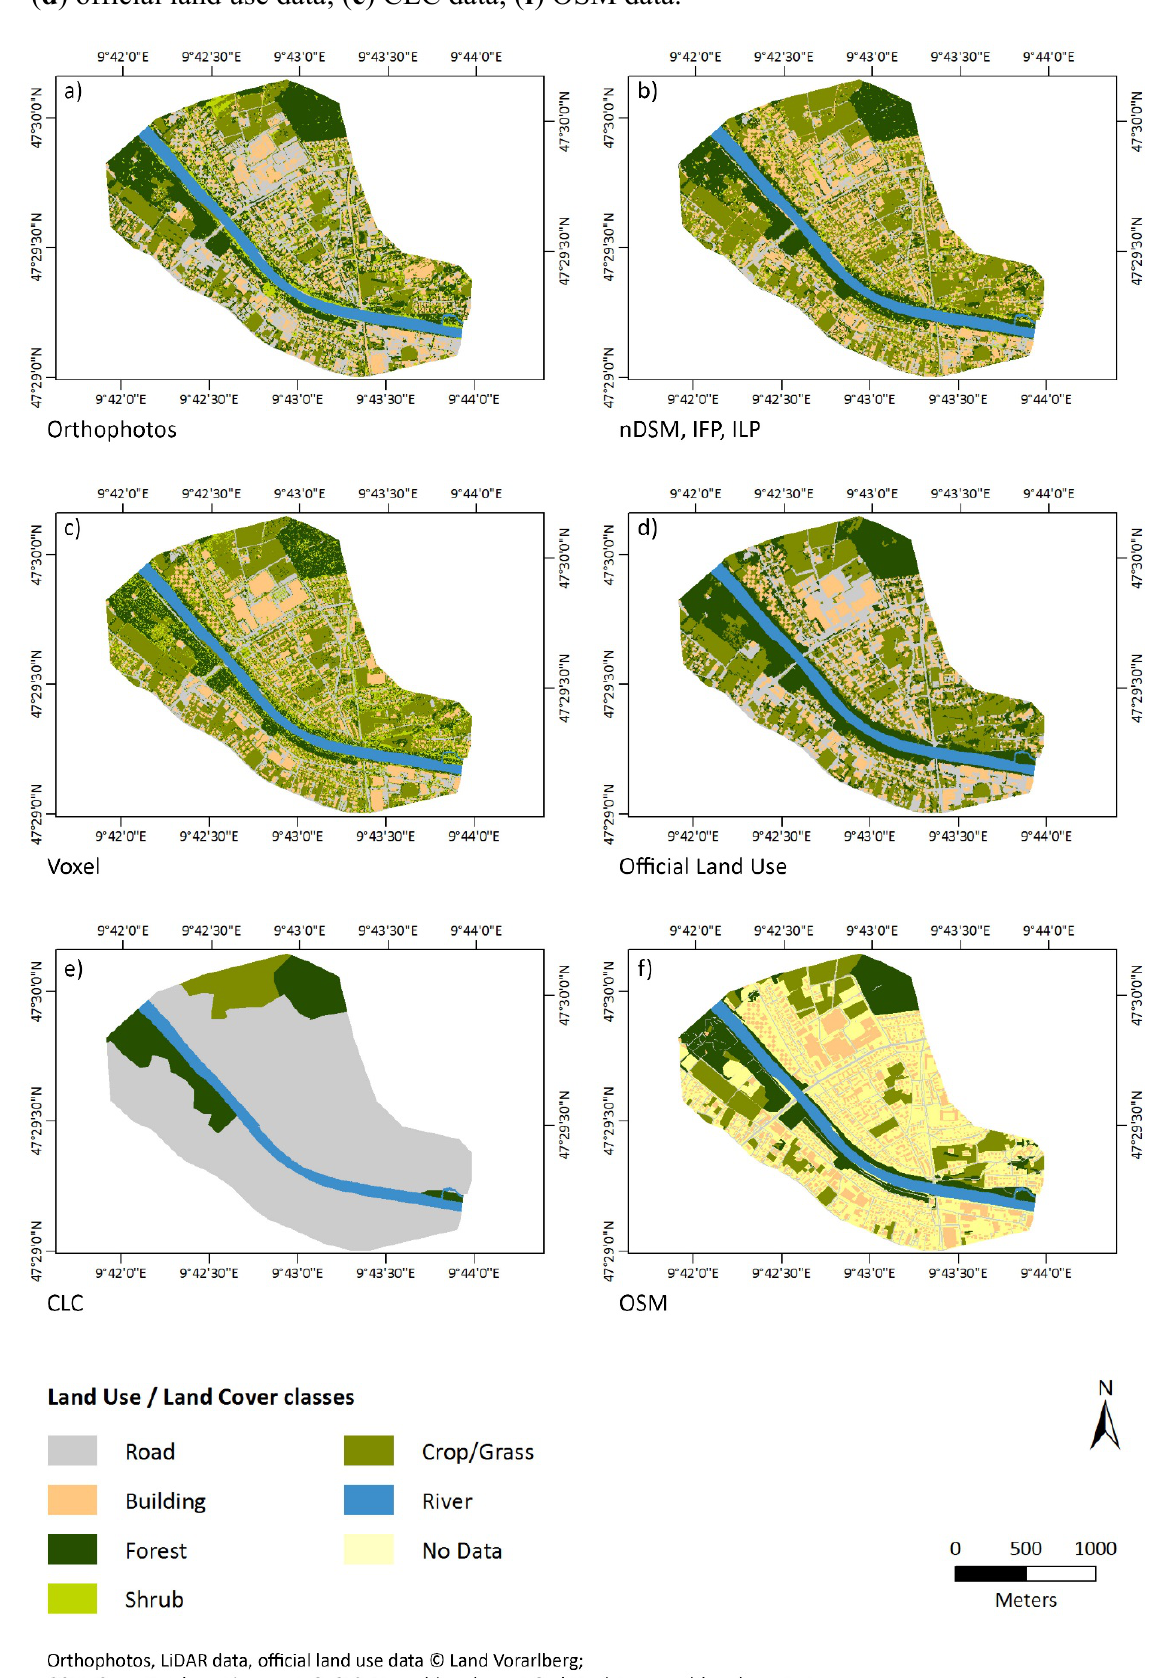
Figure 3. LULC classifications based on ( a ) orthophotos; ( b ) nDSM, IFP, ILP; ( c ) voxel; ( d ) official land use data; ( e ) CLC data; ( f ) OSM